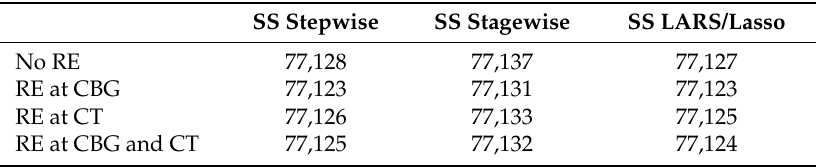
Table 13. AIC comparisons among SS forward stepwise-, SS forward stagewise, and SS LARS/lasso- based models with interactions and varying random effects (RE): no RE, RE at CBG, RE at CT, and RE at CBG and CT. SS Stepwise SS